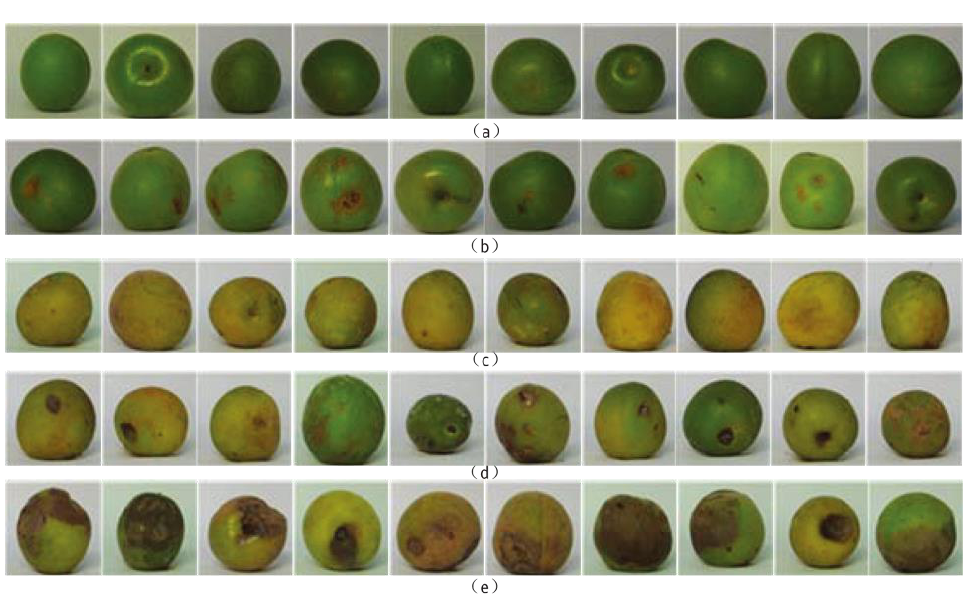
Figure 5. Cognitive accuracy vs. parameters of bagging SCN classifier: ( a ) performance with vari- ous 𝐿 values and ( b ) performance with various 𝑛 ℎ values. Figure 6 shows the average cognition accuracy ρ for different training dataset do- mains |𝑈| with convolution feature extraction using our information entropy-based method and other fixed feature map-based methods ( 𝑚 = 3 , 𝑚 = 6 , 𝑚 = 12 , and 𝑚 = 18 ) in the open-loop experiment, in which the feature level 𝑙 = 1 and fixed correspond- ence parameters were taken as an example. The information quantity required for classi- fication increased with the sample domain, but the feature extraction method based on